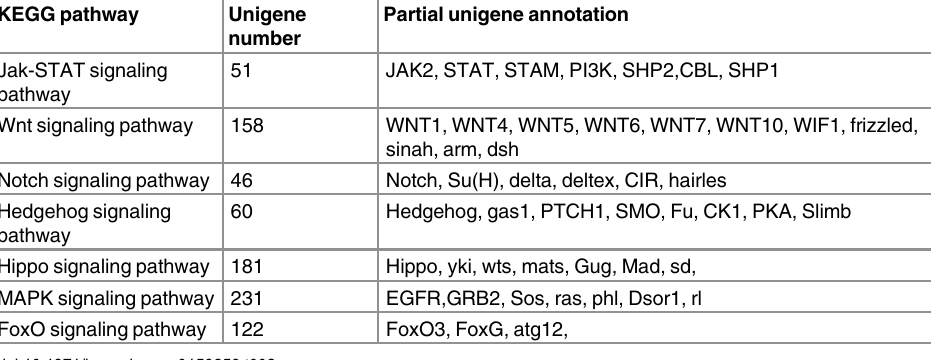
Table 2. Development related pathways and partially annotated key